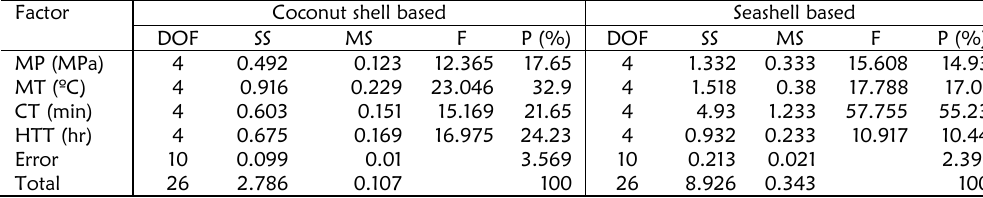
Table 9: ANOVA for wear